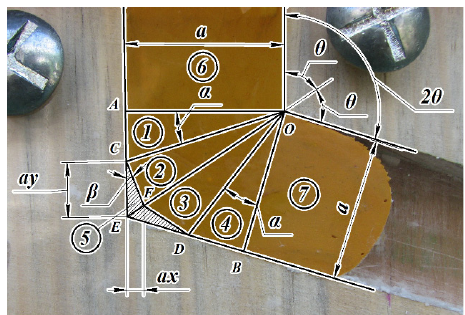
Figure 6. Physical model of the shape of material dead zone CEDF during ECAE through a Segal 2θ -die with channel intersection angle 2θ=105°